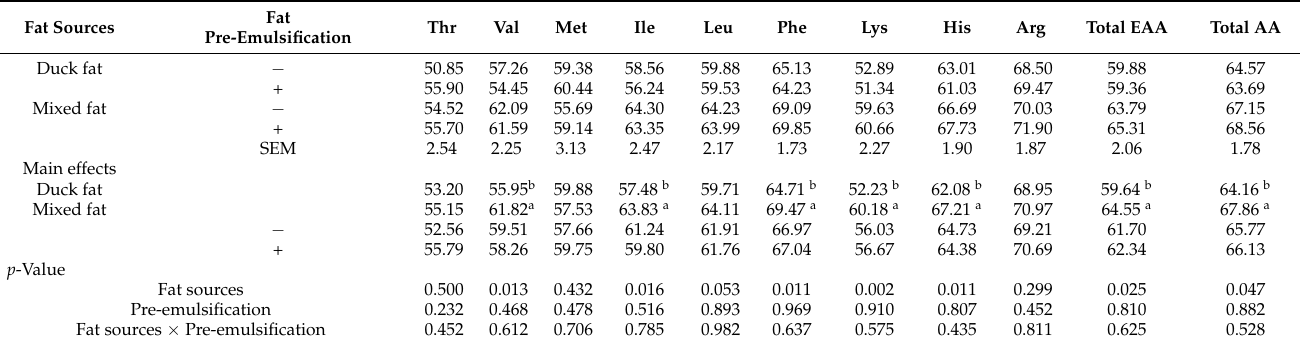
Table 8. Effects of fat sources and pre-emulsification on standardized ileal digestibility of essential amino acids of ducks at 40 days of age (%) 1,2